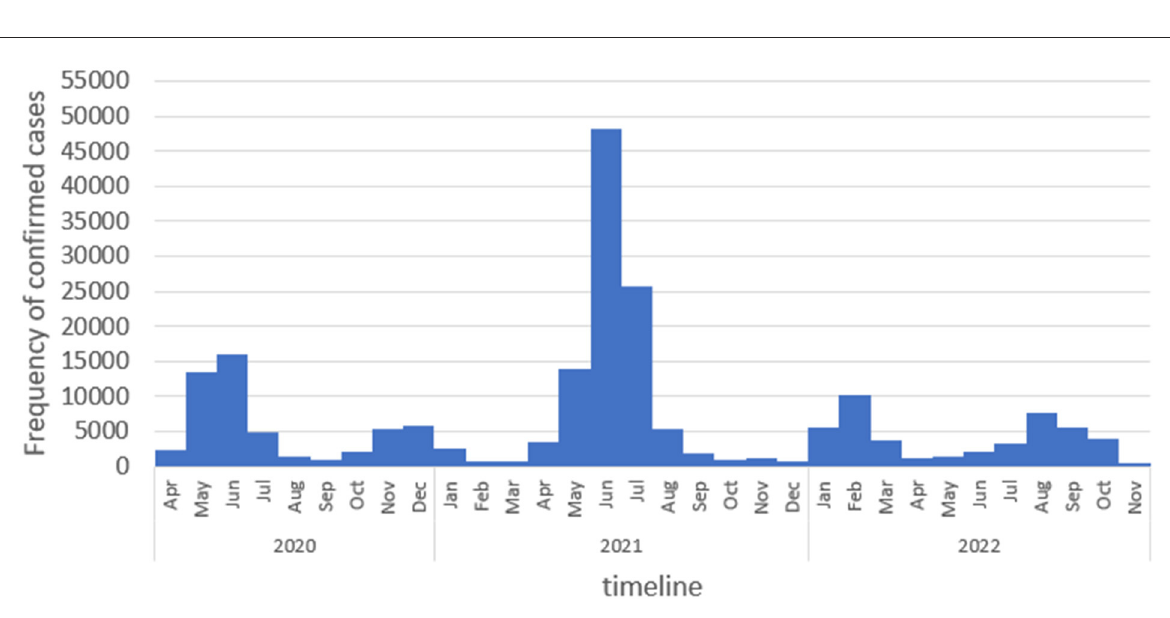
care. Data collection was conducted in February 2022; facility managers were asked to report on changes in health service